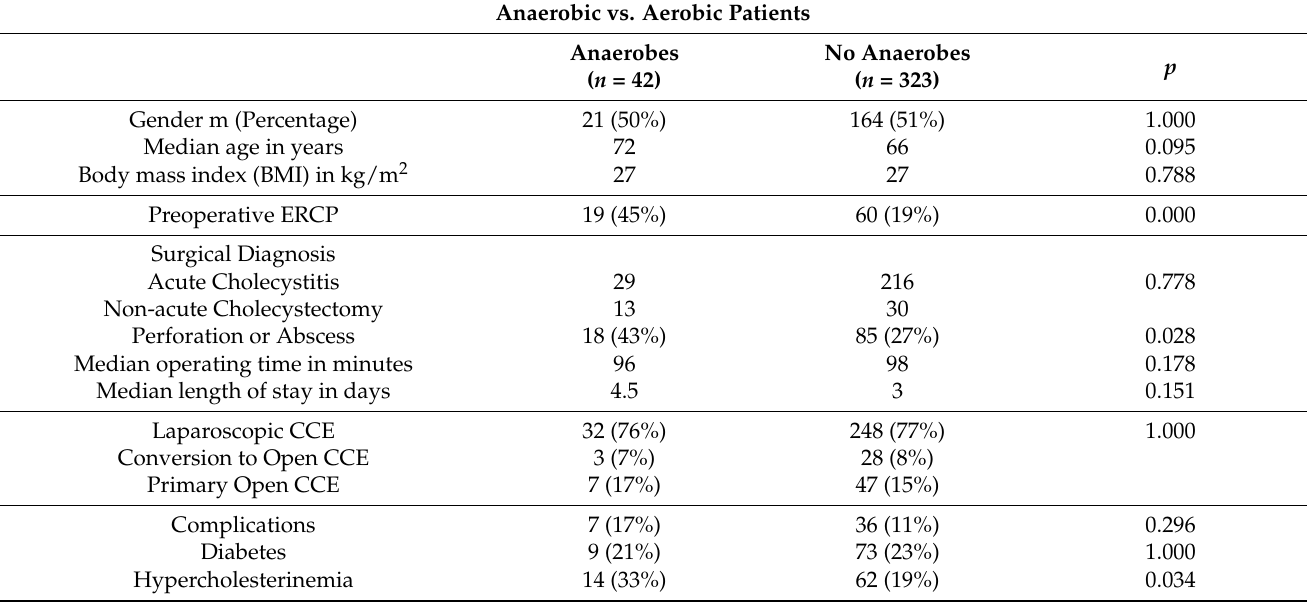
Table 2. A comparison of the patients with anaerobic infection (first column) and the patients without anaerobic growth (second column).